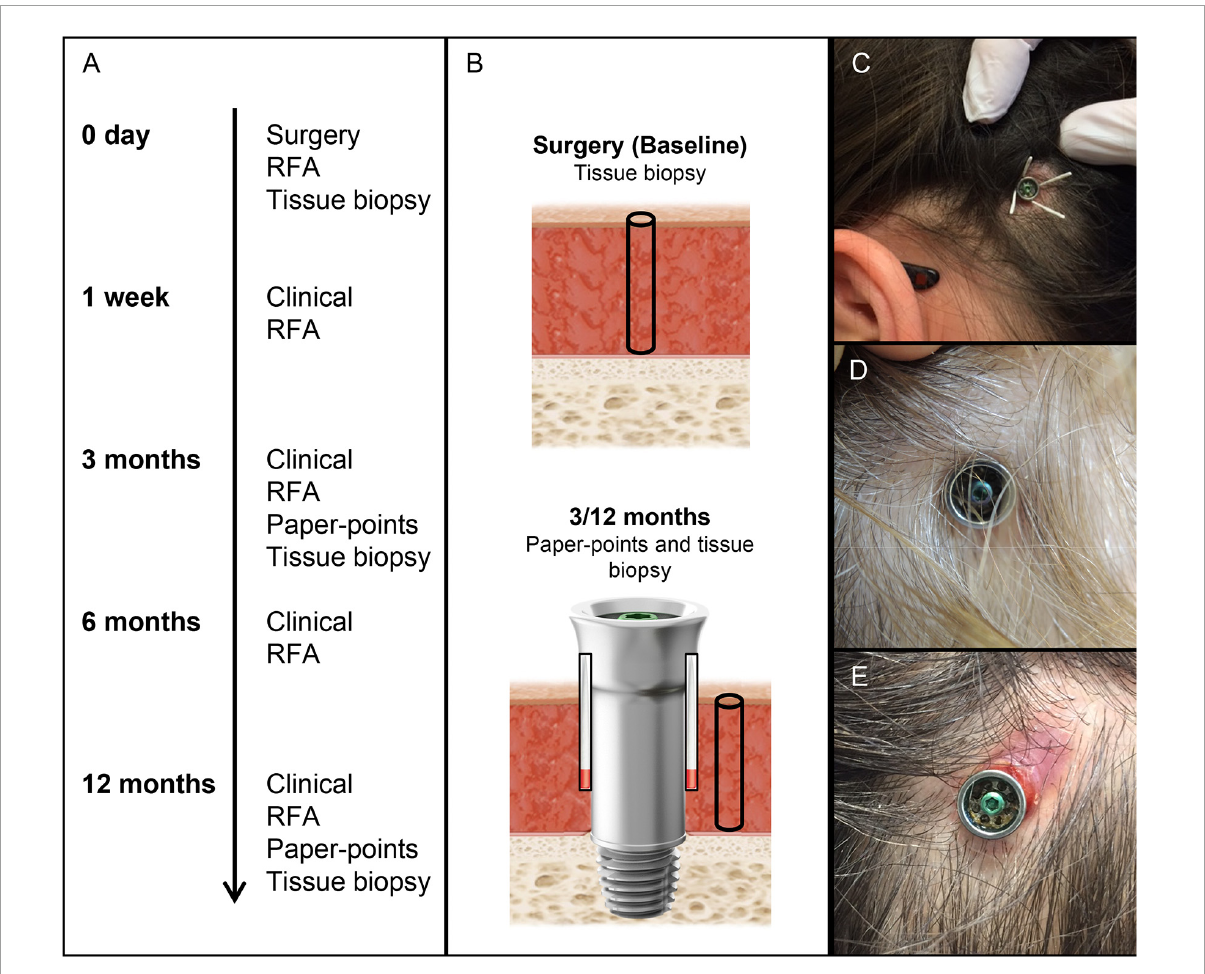
FIGURE1 Timeline, sampling, and clinical photographs of BAHS. (A) Timeline and analytical procedures at each time period. (B) Sampling baseline tissue (biopsy for gene expression and CFU) and peri-abutment fluid (paper points for gene expression and CFU at 3 and 12 months), surrounding soft tissue (biopsy for gene expression and CFU at 3 and 12 months), and abutment (for CFU at 3 and 12 months). (C) Sampling of peri-abutment fluid with paper points. (D,E) Clinical picture of Holgers scoring 0 (D) and 3 (E) after 3 months of implantation. CFU, Colony Forming Unit; RFA, Resonance Frequency